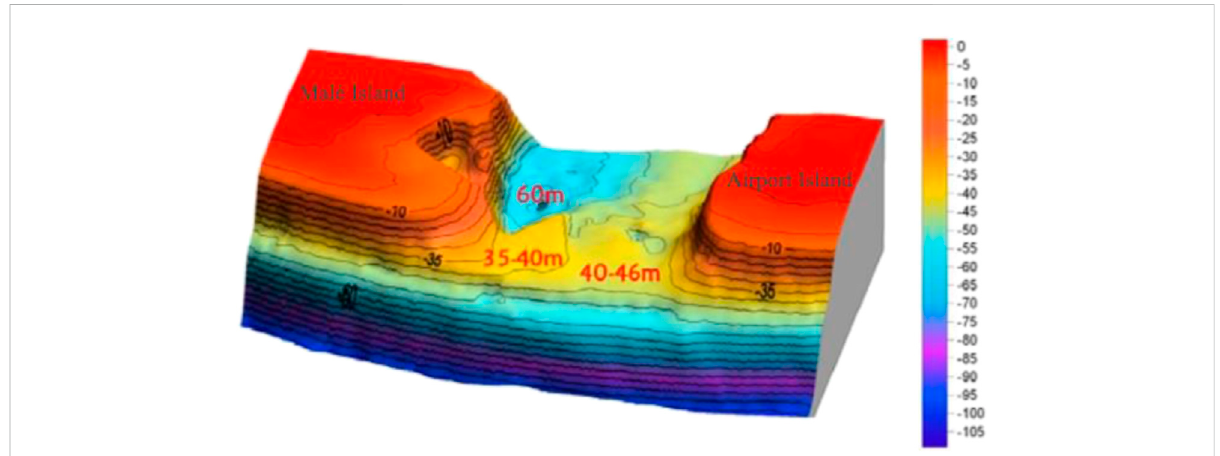
FIGURE 2 Contour map of water level in Gaadhoo Koa